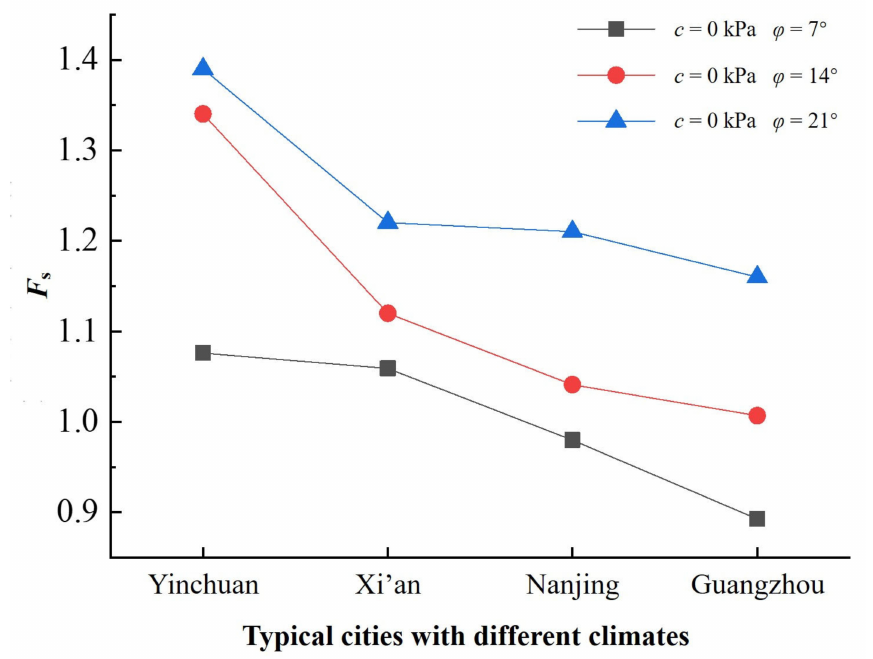
Figure 13. Influence of climate on landfill slope stability.